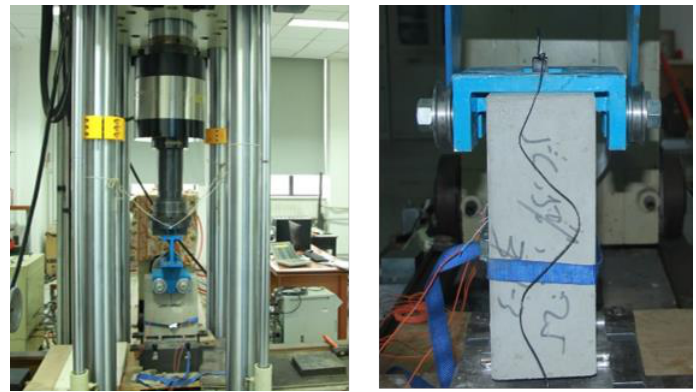
Figure 2. The fracture experiment set-up.